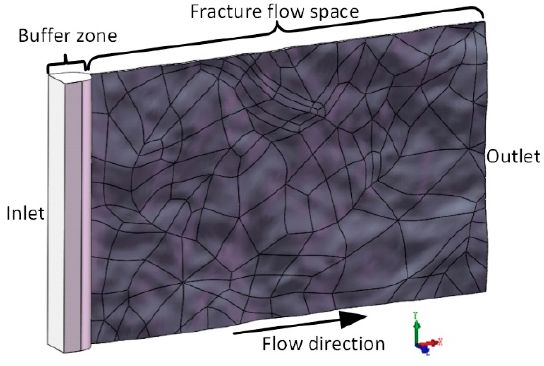
Figure 4. Geometric model of numerical simulation.